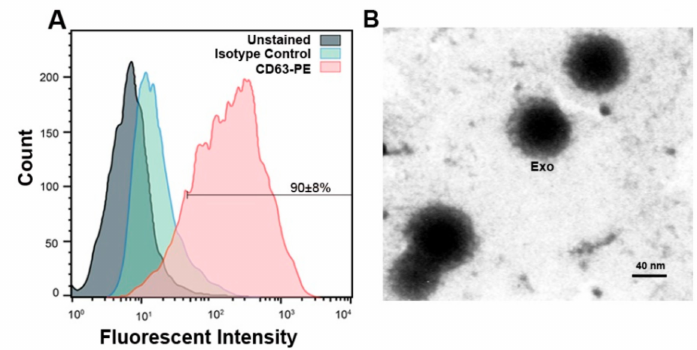
Figure 5. ( A ) Flow cytometric data confirmed exosomes by identifying exosomal marker CD63 and 90 ± 8% of exosomes in suspension represented CD63 marker. ( B ) Representative micrograph from transmission electron microscopy showing the nano-sized exosomes (Scale bar 40 nm). Exo: exosomes.